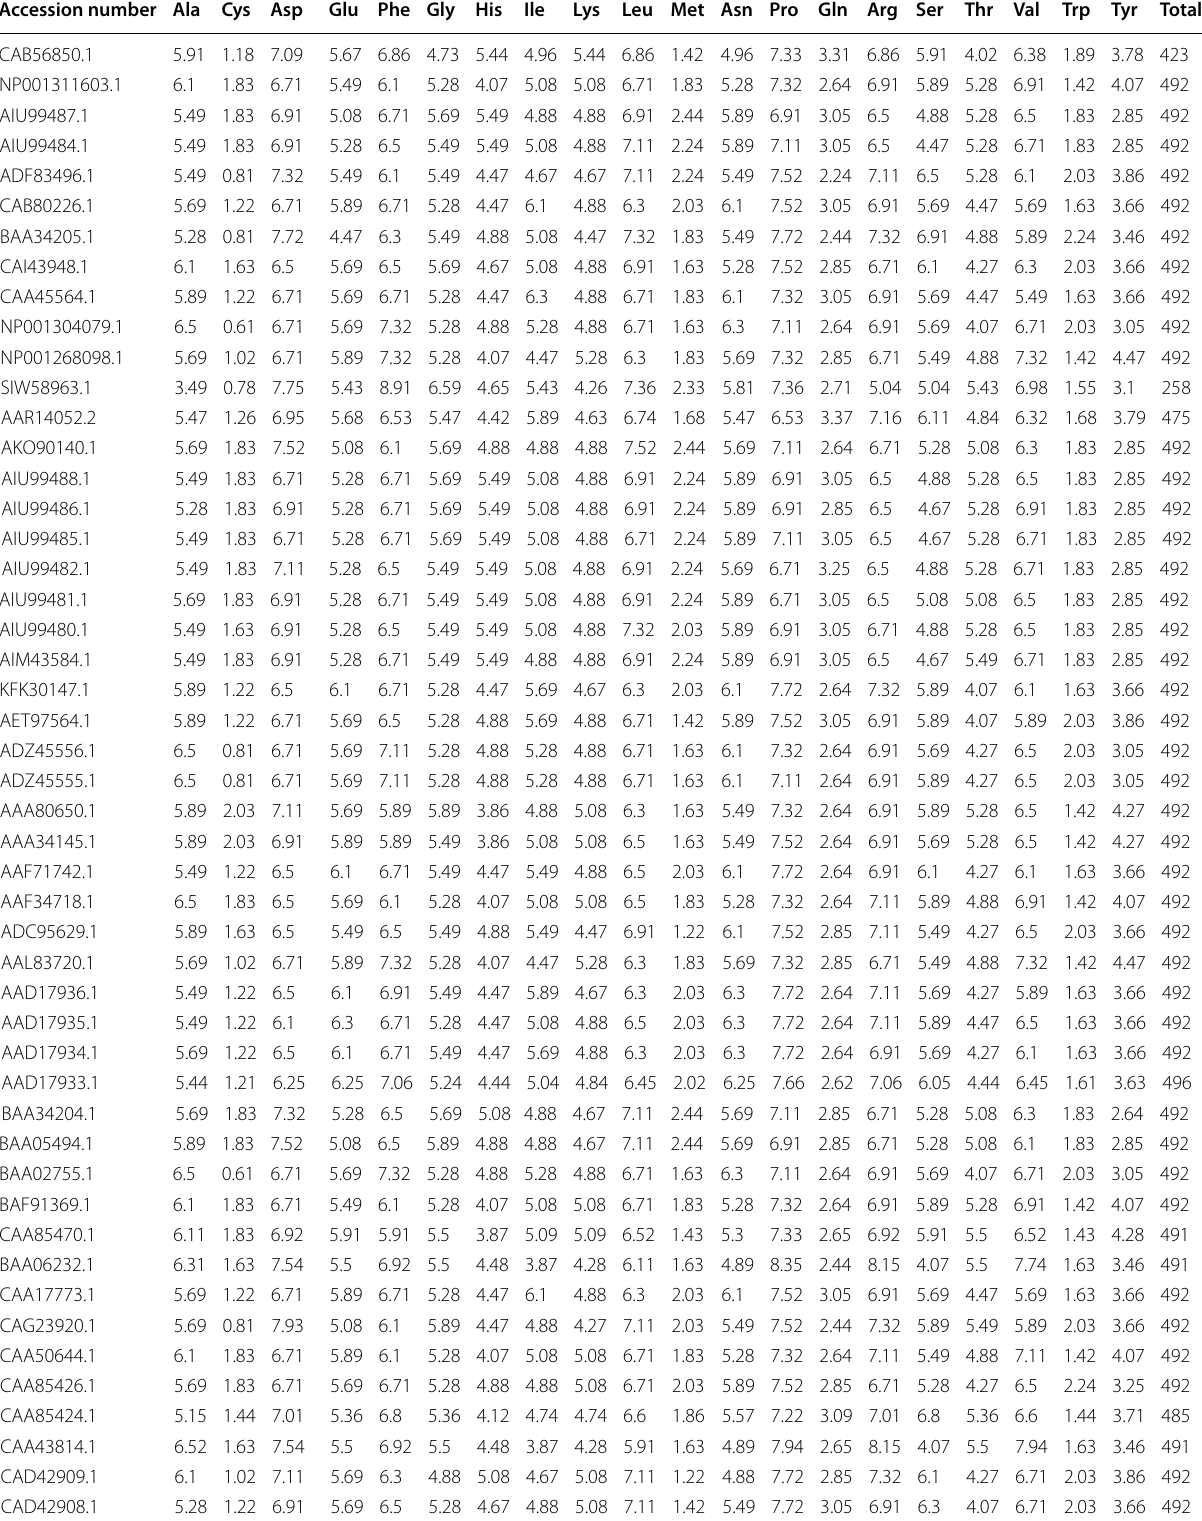
Table 4 Amino acid composition (%) of CAT protein from different plant